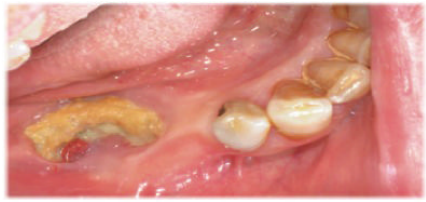
Figure 1: Sample of patients affected by BRONJ.